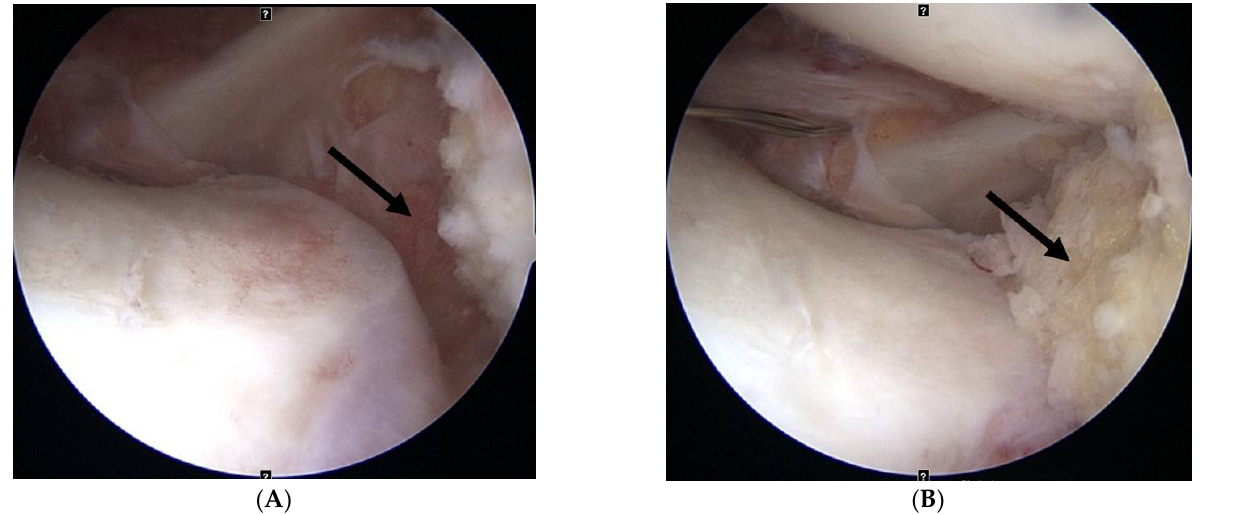
Figure 4. ( A ) The lateral capsule is displaced from the lateral tibial plateau previous to capsulodesis. ( B ) The lateral capsule is attached to the lateral tibial plateau after capsulodesis.